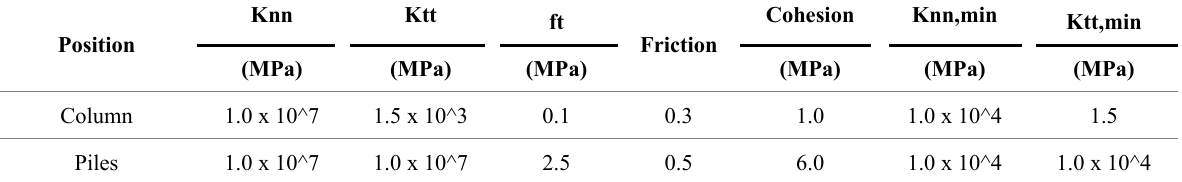
Table 2. Mechanical properties of interface elements in models B110R4LI and B127R2.5LI